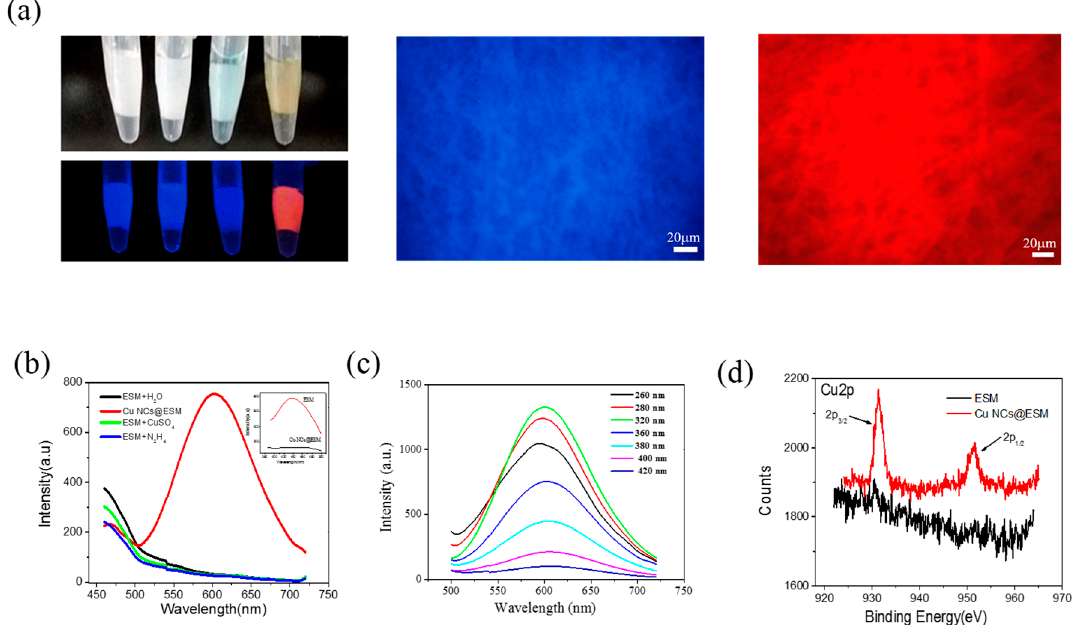
Figure 1. Characterization of ESMs embedded with or without CuNCs. ( a ) Room light (upper panel) and UV light (lower panel) photos of Cu NCs@ESM and controls. Samples from left to right correspond to ESM in H 2 O, ESM in N 2 H 4 · H 2 O, ESM in CuSO 4 , and Cu NCs@ESM, respectively. The fluorescence microscopy image of ESM (middle) and as-obtained Cu NCs@ESM (right) excited by 365 nm; ( b ) Fluorescence emission spectra of 1–4 samples excited by 365 nm. Inset: fluorescence spectra of ESM itself before and after loading Cu NCs in the blue light region; ( c ) Fluorescence emission spectra of Cu NCs@ESM with varying excitation wavelengths from 260 to 420 nm; ( d ) XPS spectra of the Cu NCs@ESM and ESM in the Cu 2p region.